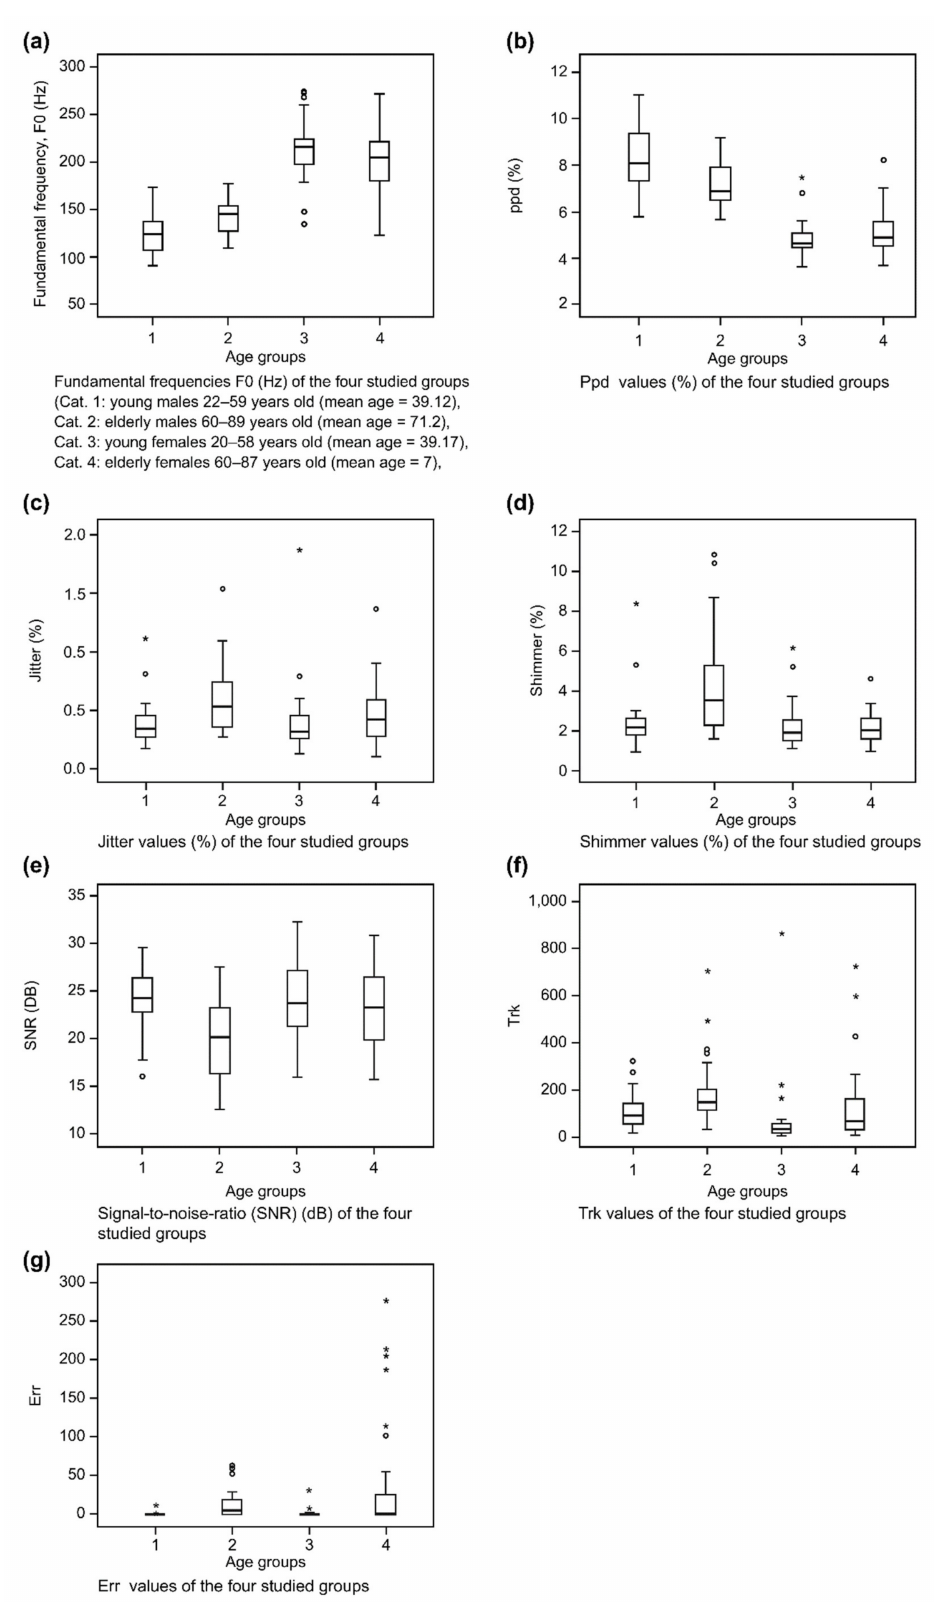
Figure 2. Distributions of acoustic parameters analyzed with